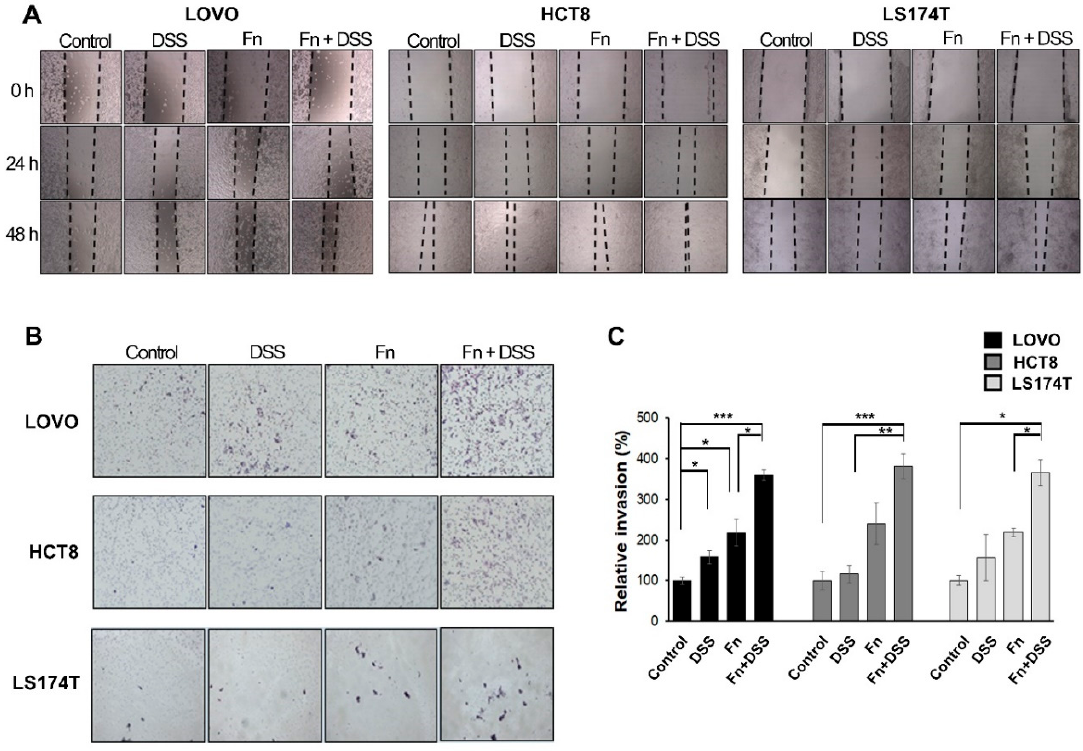
Figure 3. F. nucleatum increases the motility of CRC cells under DSS stimulation. ( A ) Wound-healing assay of CRC cells co-cultured with vehicle, DSS, F. nucleatum , or F. nucleatum + DSS and monitored for 48 h with 24 h intervals. 40 times magnification. ( B ) Transwell-invasion assays were conducted with CRC cells co-cultured with vehicle, DSS, F. nucleatum , or F. nucleatum + DSS. 100 times magnification. ( C ) Graph showing the percentage of invaded CRC cells. The indicated invaded cells were quantified in five randomly selected fields. The graph represents relative levels from three independent experiments. The data are presented as the mean ± SEM (* p < 0.05, ** p < 0.01, and *** p < 0.001; unpaired Student’s t -test). Abbreviations: DSS, dextran sodium sulfate; Fn, F. nucleatum .